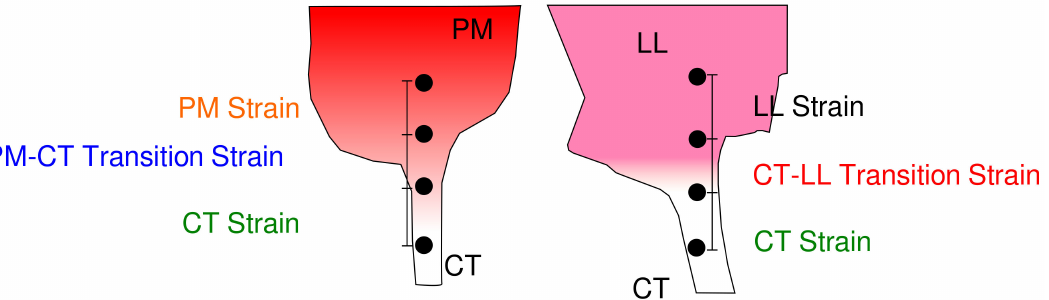
Figure 8. An illustration of location of fiducial markers placed on samples for tracking using the TrackMate plugin on Image J. Markers are placed so that each region (PM, CT and LL) have at least have one marker and one on each side of the visible transition in each sample